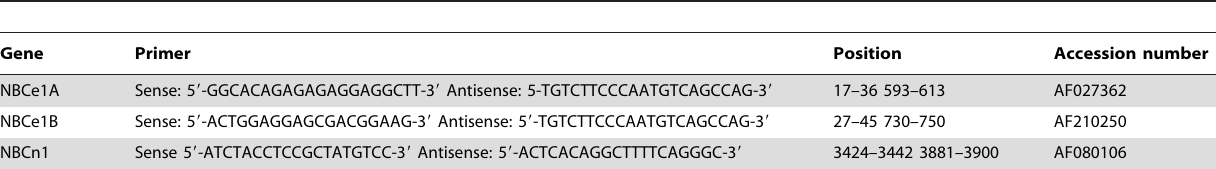
Table 2. Gene specific primers used for RT-PCR analyses: bNBC1 (brain NBC1), kNBC (kidney NBC1), NBC2 (NBCn-1b) and NBC3 (NBCn1-d) isoform specific primers were designed from published sequences.